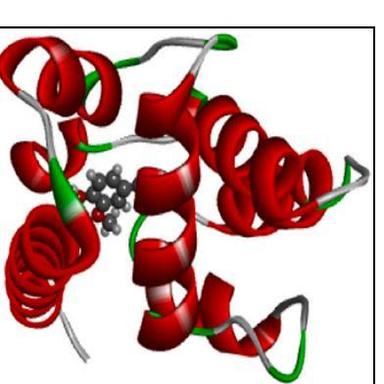
Location of the best docked poses of the ligands homoguaiacol, apocynin, guaiacylacetone, homovanillyl alcohol and 4-ethylguaiacol in the mouse eugenol olfactory receptor estimated via a docking calculation by iGEMDOCK.